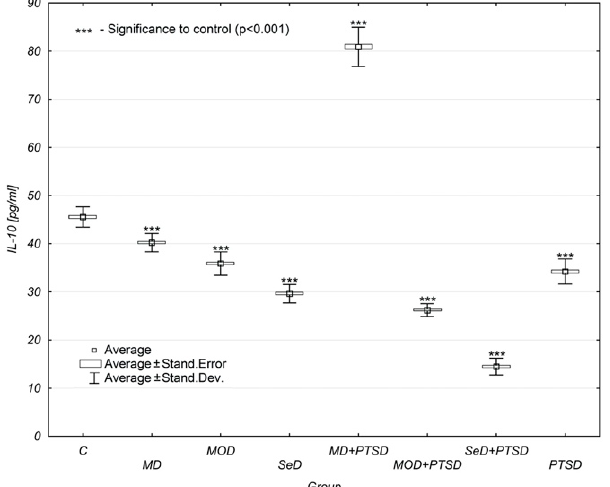
Figure 4. Mean IL-10 concentration levels in selected study groups. Legends: C—control group, MD—mild depression; MOD—moderate depression; SD—severe depression; MD + PTSD—mild depression + posttraumatic stress disorder; MOD + PTSD—moderate depression + posttraumatic stress disorder; SeD + PTSD—severe depression + posttraumatic stress disorder; PTSD—posttraumatic stress disorder; IL-10—interleukin-10. Number of patients in the study groups (females + males): C = 80, MD = 120, MOD = 120, SD = 120, MD + PTSD = 120; MOD + PTSD = 120; SeD + PTSD = 60; PTSD = 120. *** p < 0.005 when compared to the control group. Since all data was distributed normally, the one-way ANOVA test was used for statistical analysis (data is presented in the form of a box plot, which can be used to estimate differences in the mean values; the graphs show the mean and standard error).